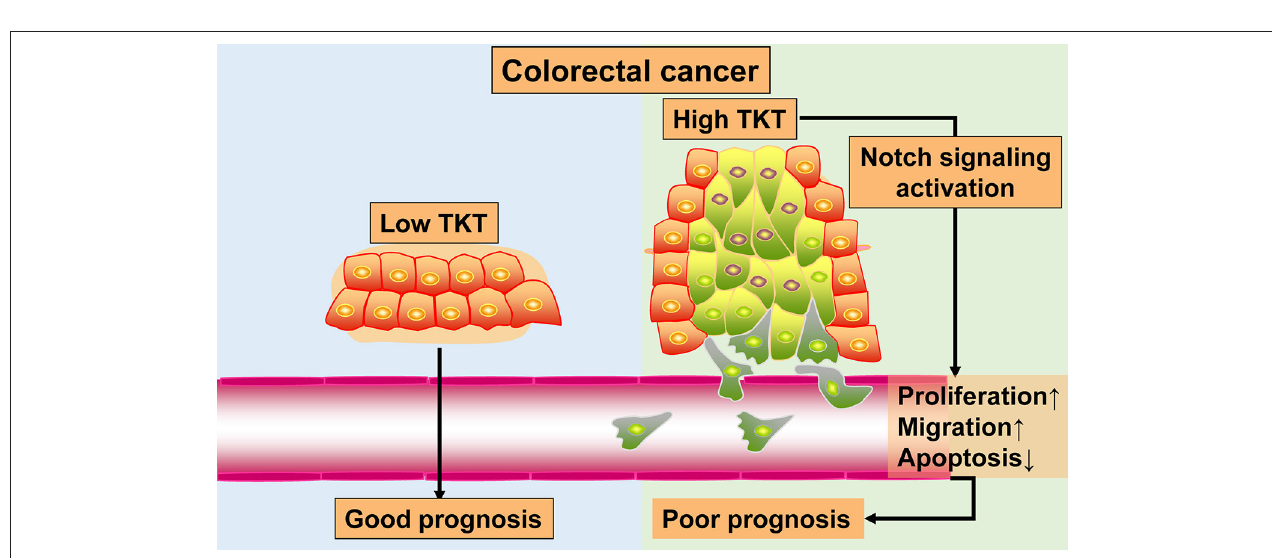
FIGURE 8 | Schematic